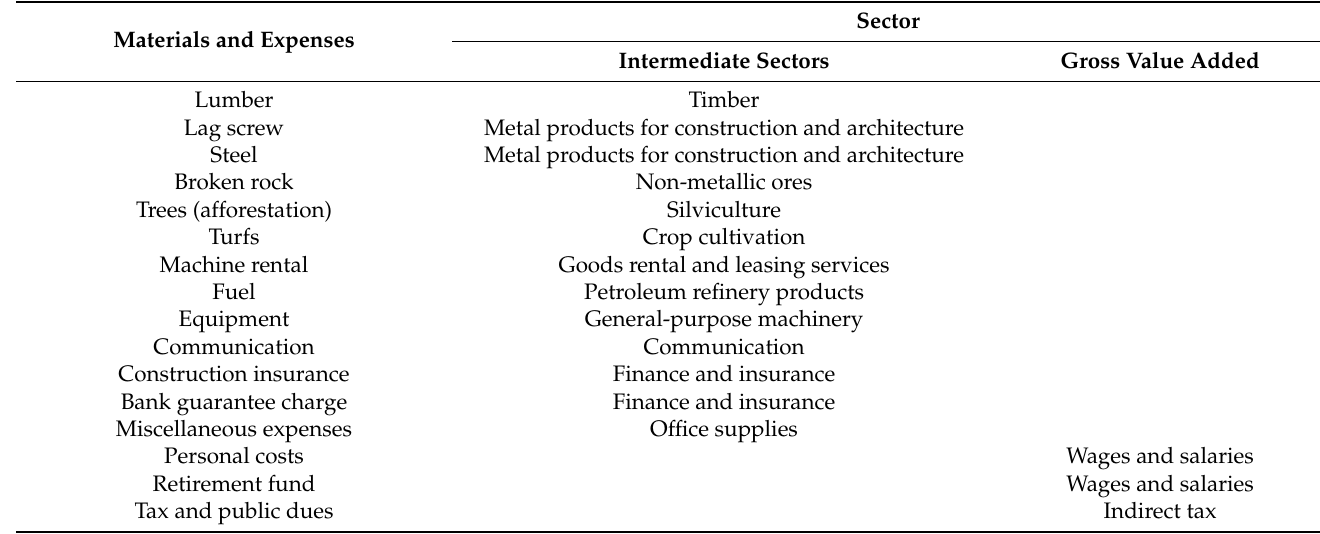
Table 1. Timber dam: The materials and expenses and the corresponding industrial sectors [19].